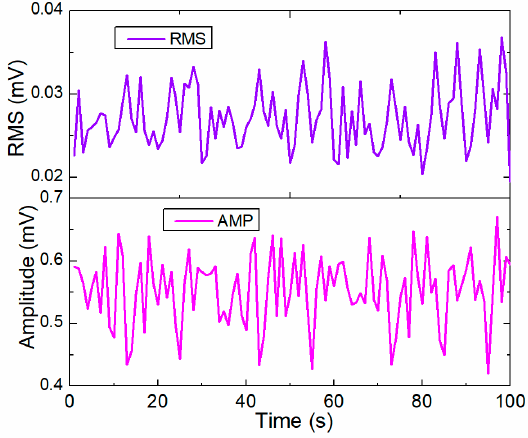
Figure 14. RMS and aptitude information from the echo signal processed by the SPA.